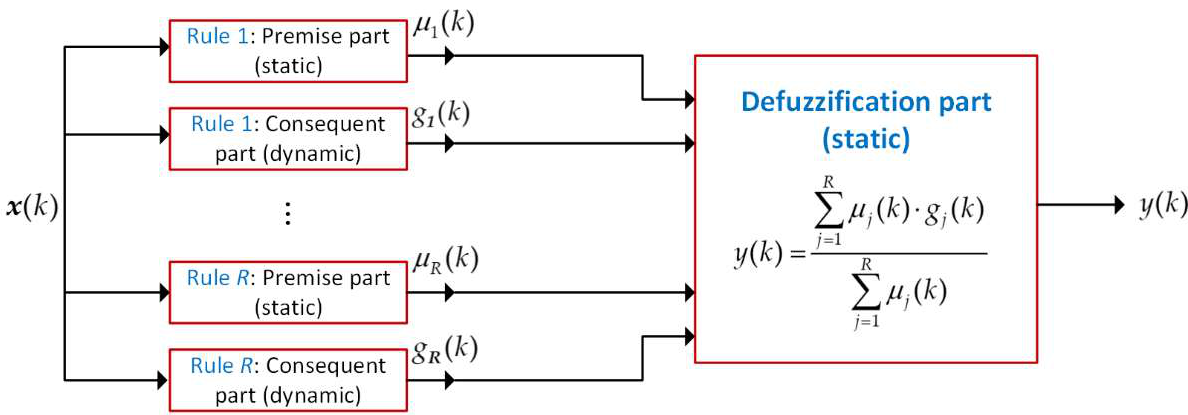
Figure 2. Block diagram of ReNFuzz-LF.